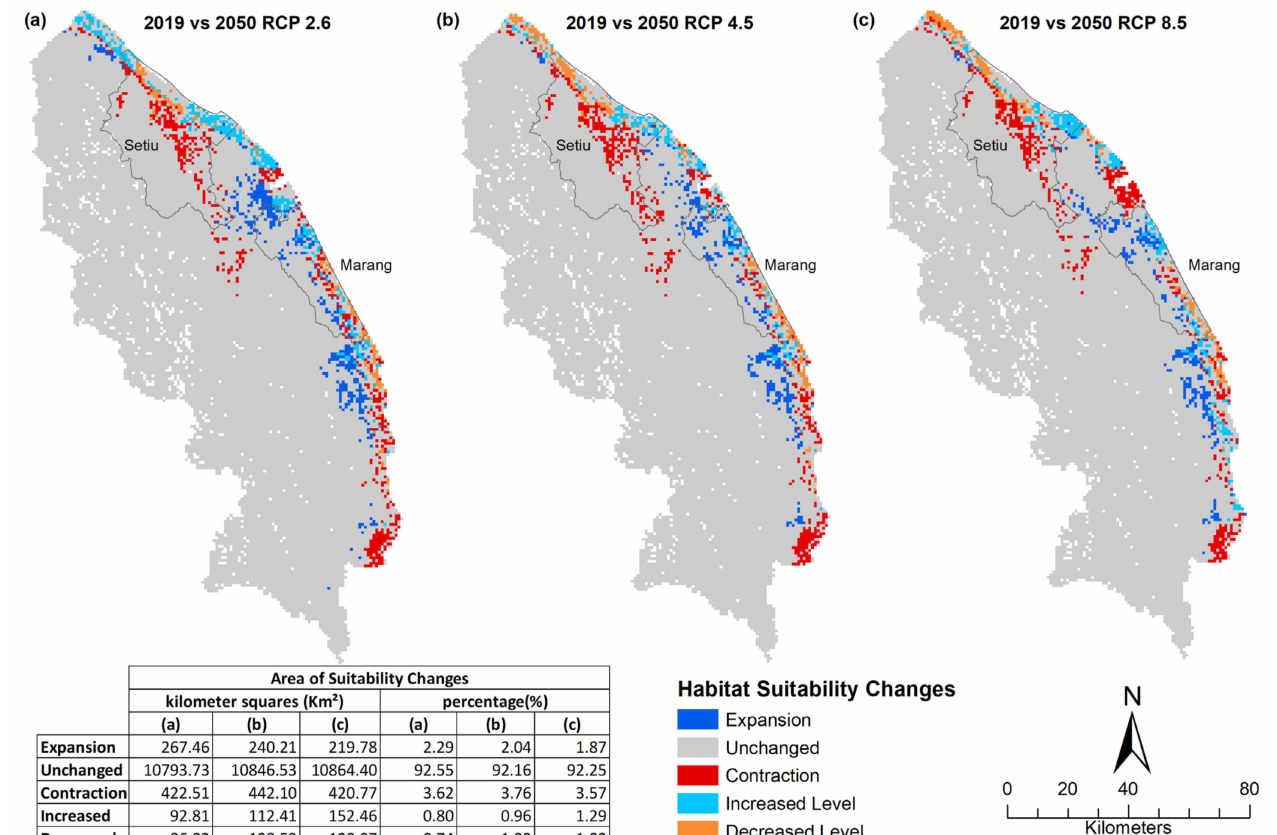
Figure 7. Habitat suitability changes from the present climate (2019) to the future year (2050) under climate scenarios: ( a ) RCP 2.6, ( b ) RCP 4.5 and ( c ) RCP 8.5. White pixel areas are the no-data pixel. Blue area marked the total expansion of habitat suitability from unsuitable to suitable habitat. Gray area is where the habitat suitability prediction remained the same and the red area marked the contraction of suitable habitat to unsuitable. Light blue and orange areas represent the changes in the level of suitability from poor to high and from high to poor,